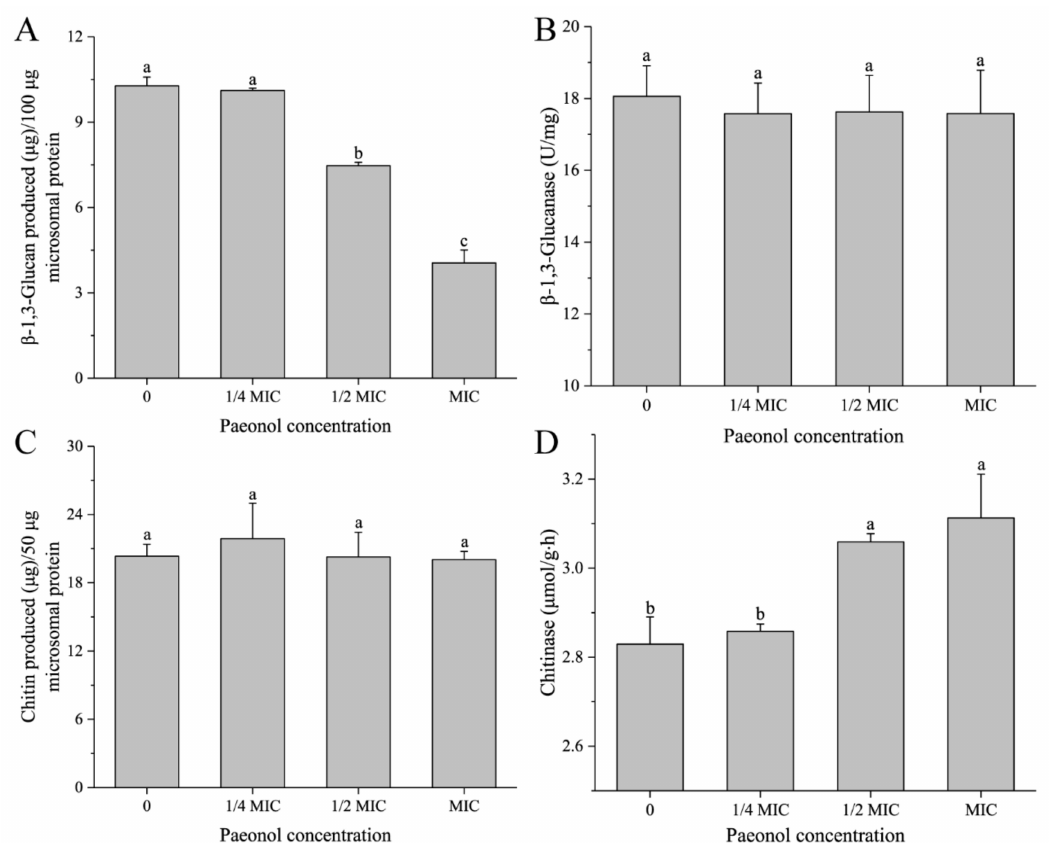
Figure 5. Activities of enzymes in the metabolisms of β -1,3-glucan and chitin in A. flavus treated with paeonol at 0, 1/4 MIC, 1/2 MIC, and MIC. ( A ) Activity of β -1,3-glucan synthase. ( B ) Activity of β -1,3-glucanase. ( C ) Activity of chitin synthase. ( D ) Activity of chitinase. a–c significant difference ( p < 0.05) according to Duncan’s multiple range